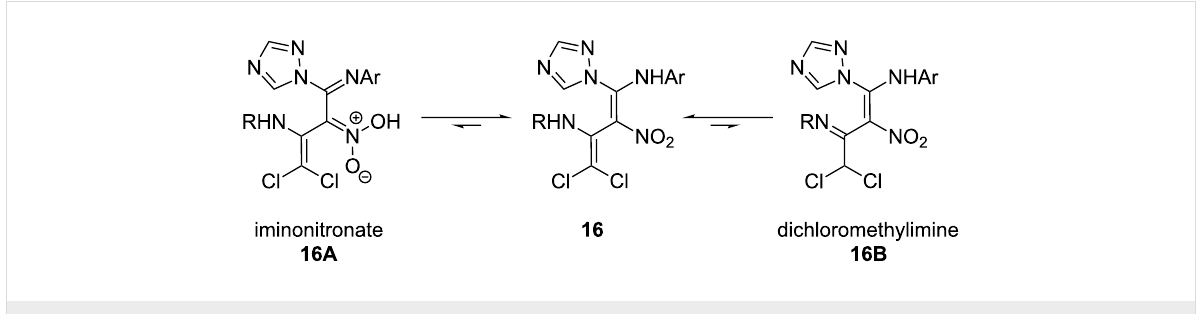
Figure 4: Conceivable tautomeric structures of 16 .